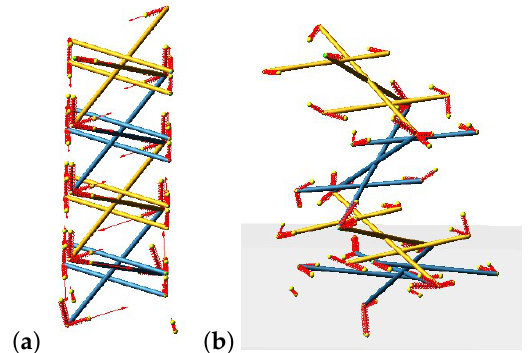
Figure 12. The octahedron column deployment: ( a ) The first deployment scheme. ( b ) The second deployment